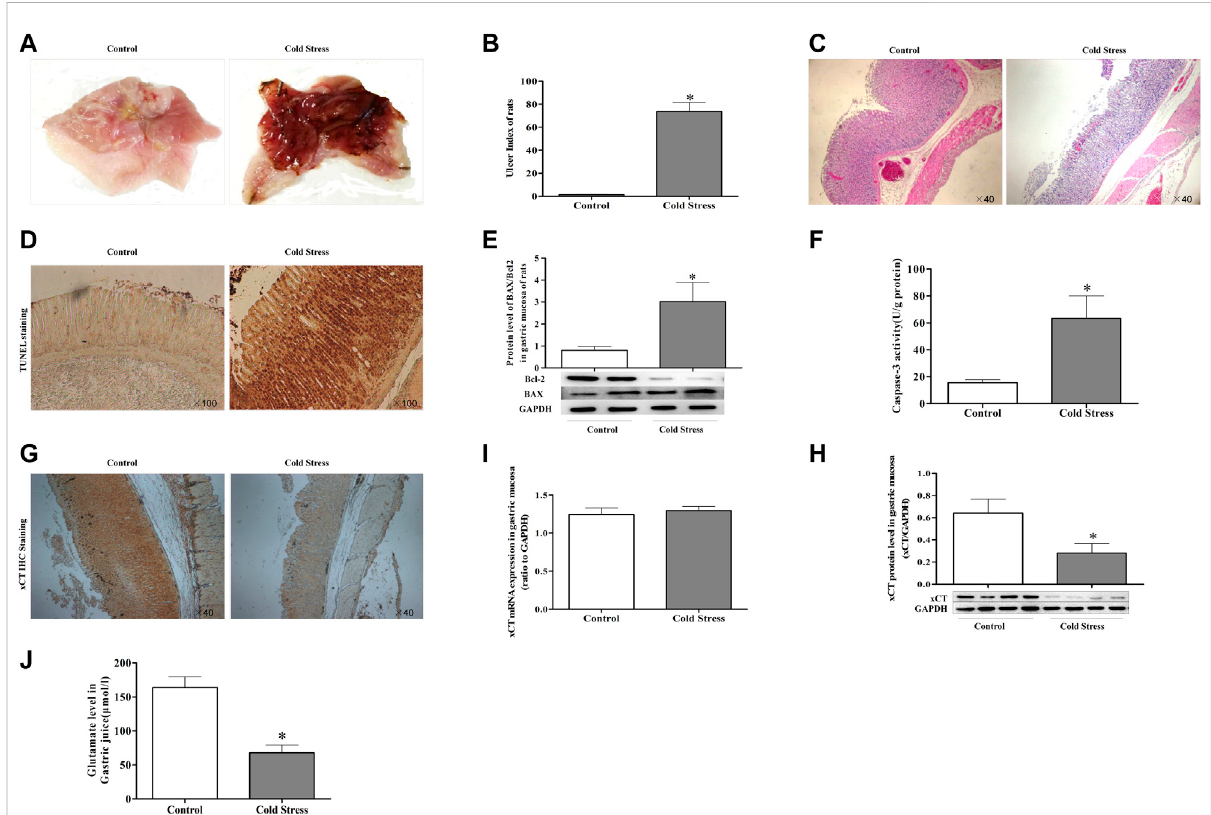
FIGURE 1 Decreased cystine/glutamate transporter (xCT) in gastric mucosa of cold-stressed rats. (A) gastric mucosa injury in rats. (B) Gastric mucosal ulcer index of rats. (C) Morphological changes in rat gastric tissue observed using light microscopy (×40). (D) TUNEL staining of gastric tissue as observedusinglightmicroscopy(×100). (E) Theratioofpro-apoptoticproteinBAXtoanti-apoptoticproteinBcl-2. (F) Activityofcaspase-3ingastric tissue. (G) xCT expression in gastric tissue (×40). (H) Protein expression of xCT. (I) xCT mRNA expression. (J) Glutamate contentin gastricjuice. Data are presented as mean ± standard error ( n = 8). * p < 0.05 vs